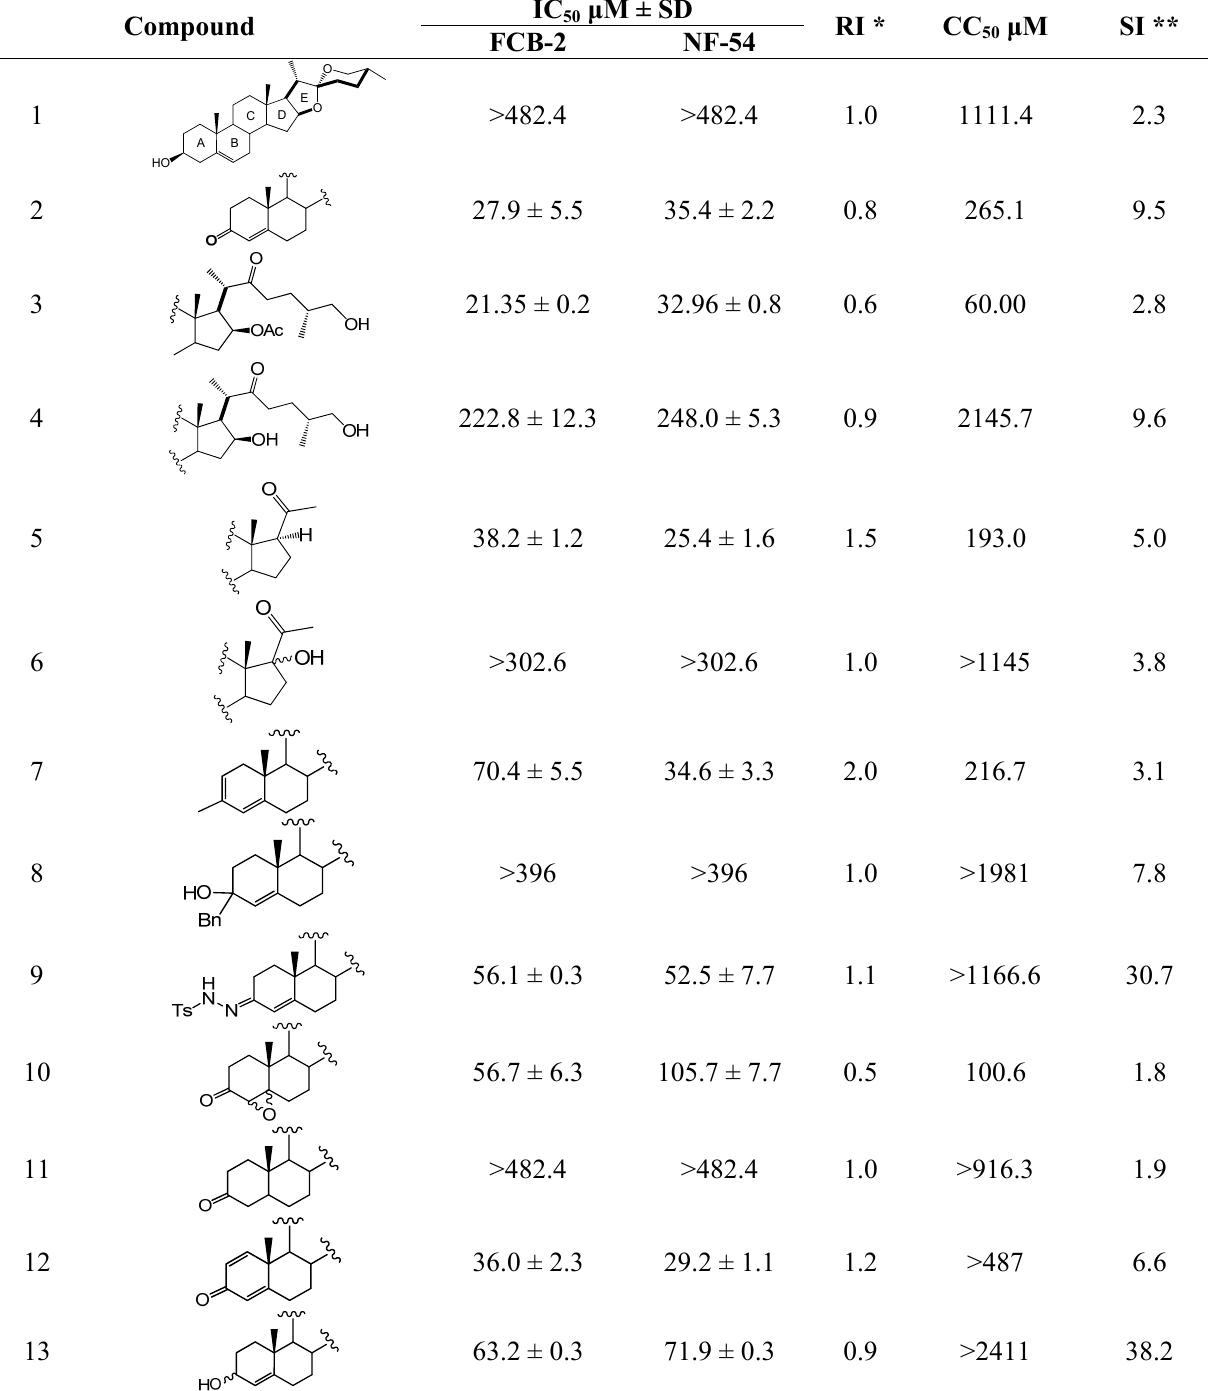
Table 1. In vitro biological activity of derivatives regarding Plasmodium falciparum FCB-2 and NF-54 strains and on HepG2A (human hepatoma cell